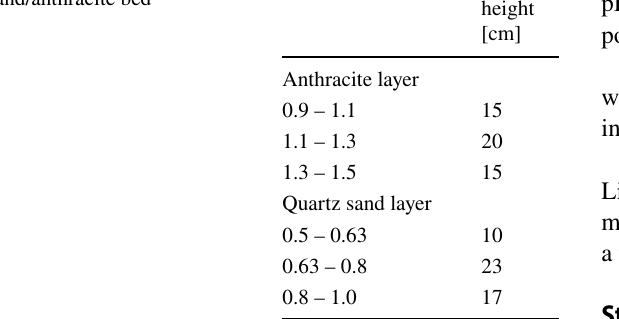
Table 1 Stratification of grains of sand/anthracite bed